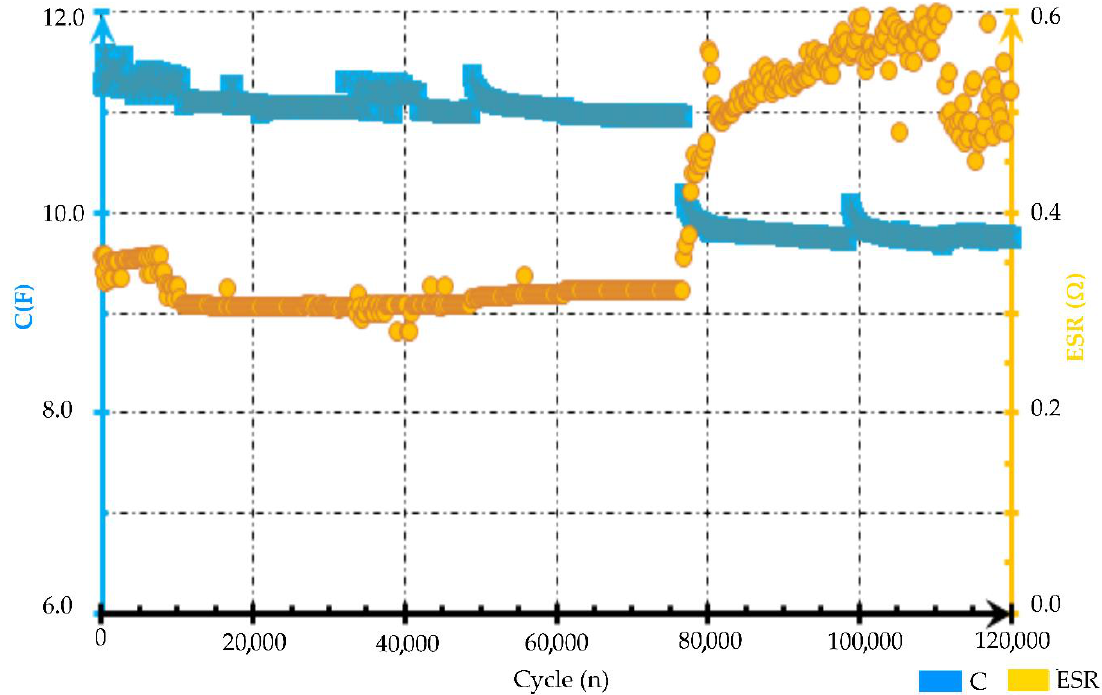
Figure 6. Capacitance C and equivalent serial resistance R ESR recorded during the test of the investigated prototype sample at a current density of 5 A/g and polarizing voltage 1.5 V.